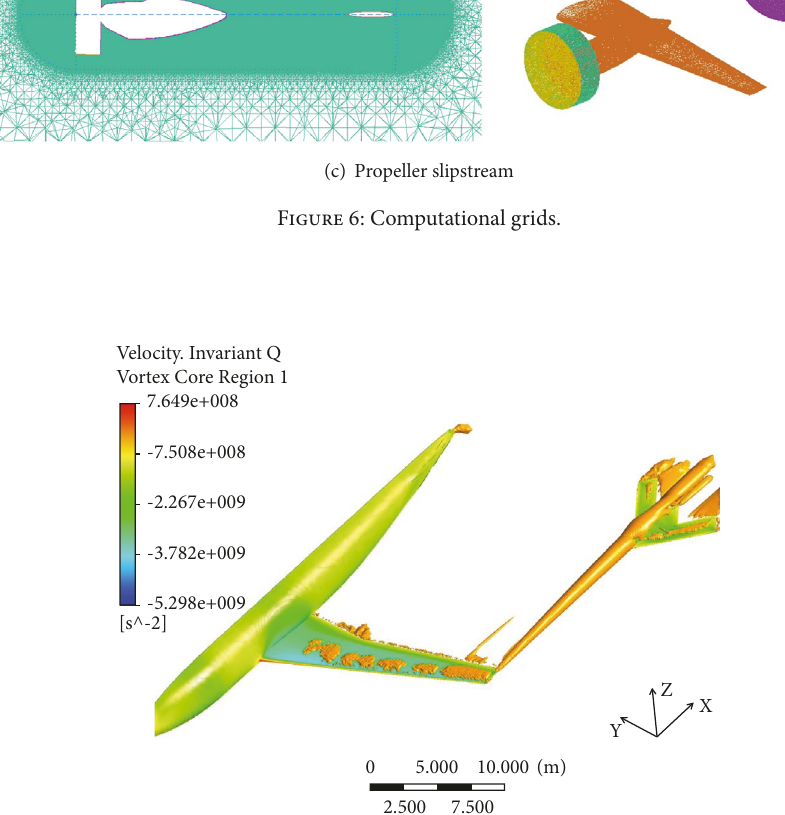
Figure 7: Wingtip vortex extends to the location of fly